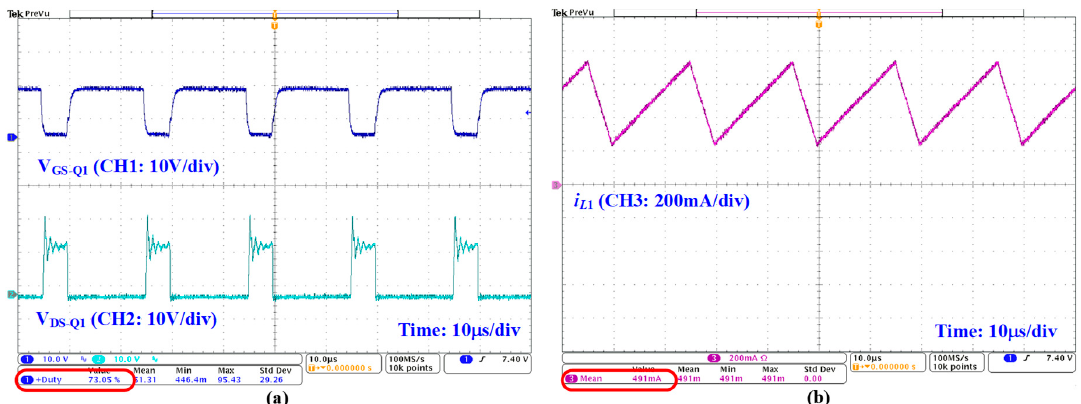
Figure 15. Measured waveforms of PCL 1 with the AVDC method: ( a ) switch voltages of V GS-Q1 and V DS-Q1 , ( b ) inductor current of i L 1 .